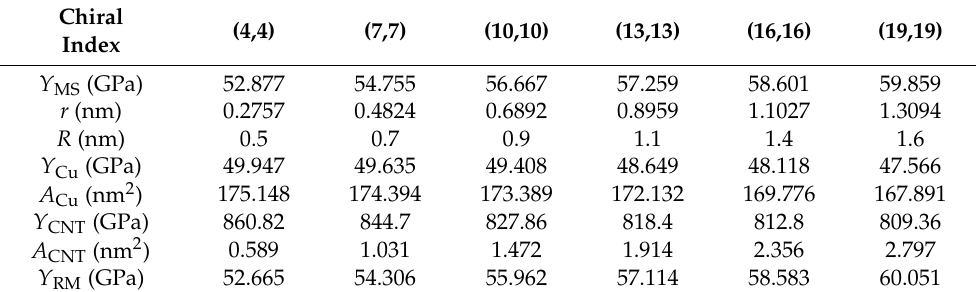
Table 3. Young’s modulus Y MS of the Cu/CNT composite calculated by the MS simulation and the parameters for calculating Young’s modulus Y RM of the system according to the Equation (5). The r and R indicate the radius of the CNT and the hole in the system,